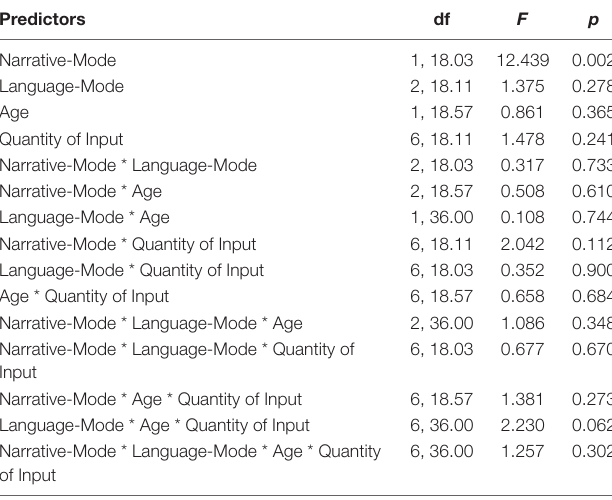
TABLE 5 | Results of the linear mixed model for the dependent variable Story Comprehension.